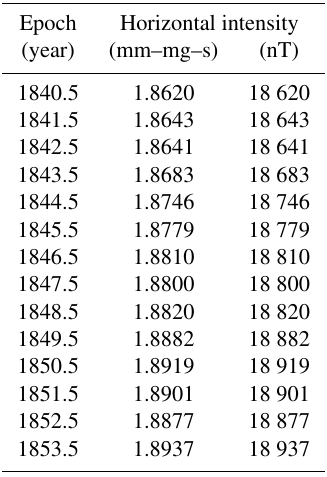
Table 5. Annual means of the horizontal intensity at the Clementinum observatory in Prague in the first years of its oper- ation. Epoch Horizontal intensity